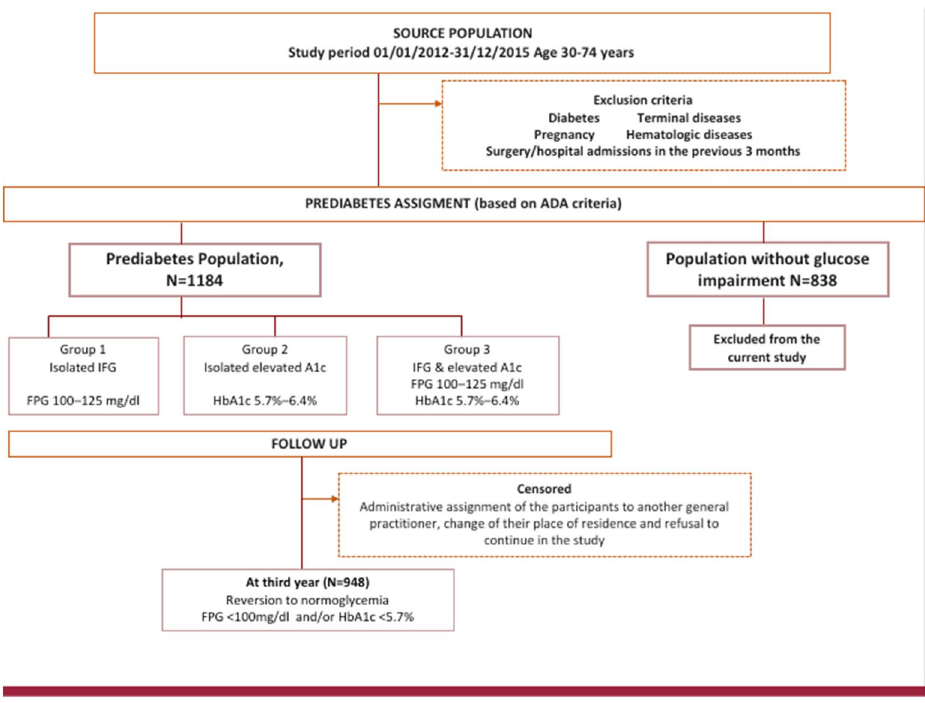
Figure 1. Proportion of patients reverting from prediabetes to normal glycaemia stratified by type of